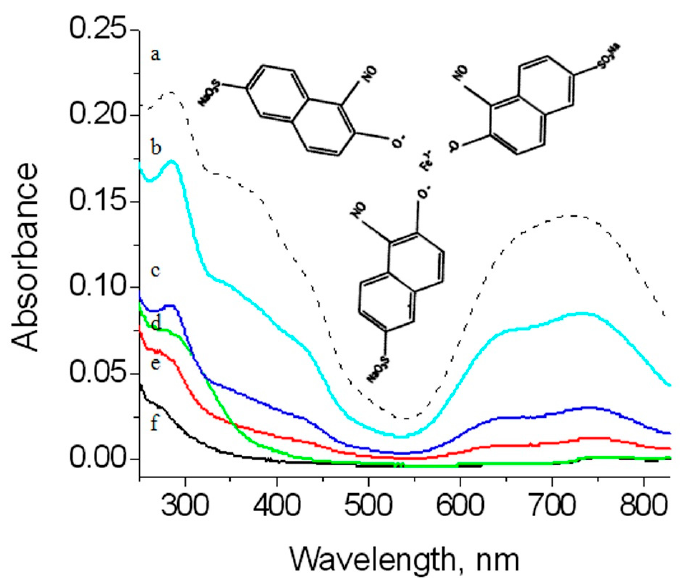
Figure 13. Absorbance spectra of naphthol green B after 10 min in sunlight ( a ) in the absence and in the presence of ( b ) BT nano commercial, ( c ) BT2-600, ( d ) BT2-900, ( e ) BT1-600 and ( f ) BT1-900.